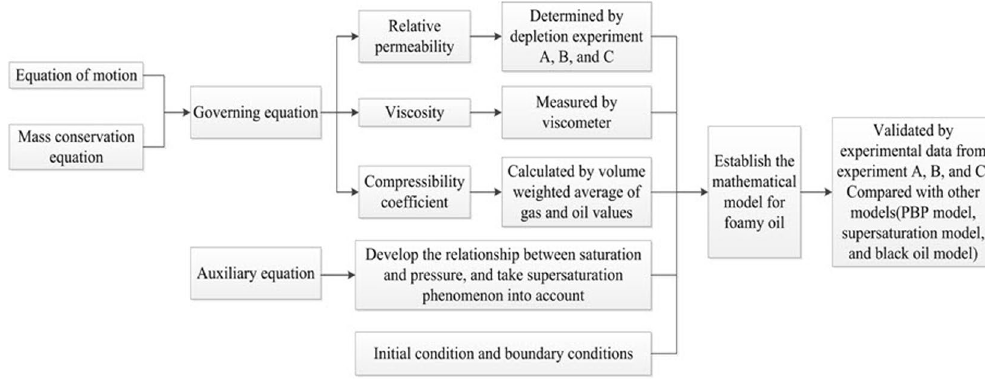
Figure 2. Workflow to illustrate the process of developing the mathematical model for foamy